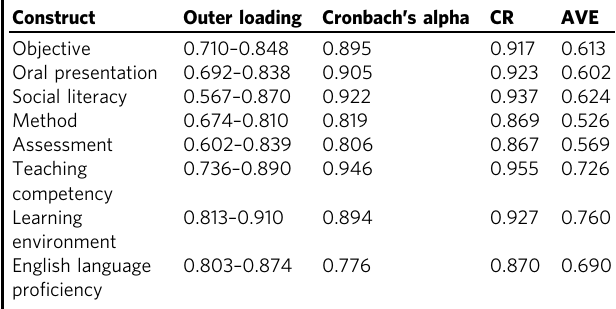
Table 4 Assessment of the initial measurement model.